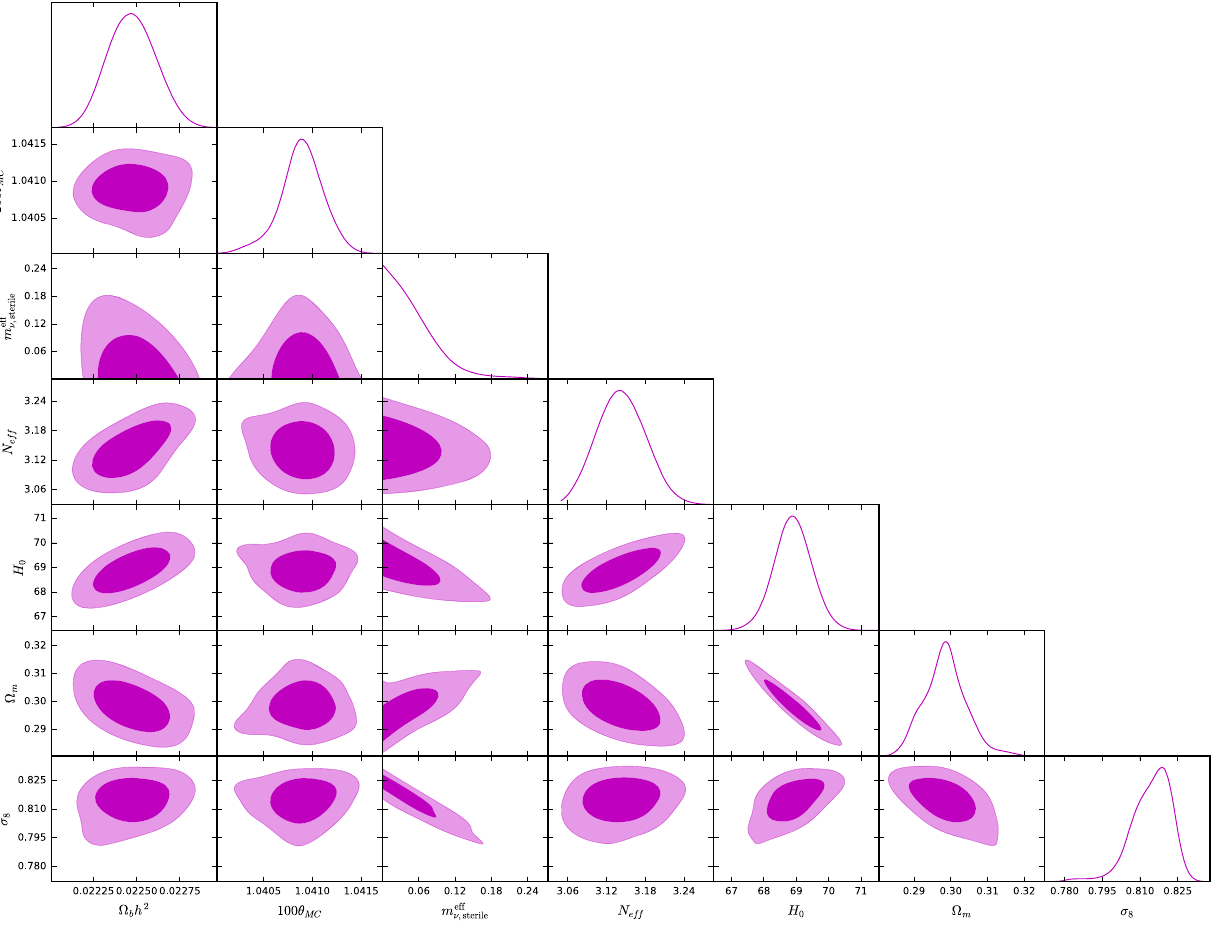
Fig. 4 The1-dimensionalmarginalizeddistributionsand2-dimensionalcontoursfortheparametersoftheFmsmodelbyusingthedatacombination